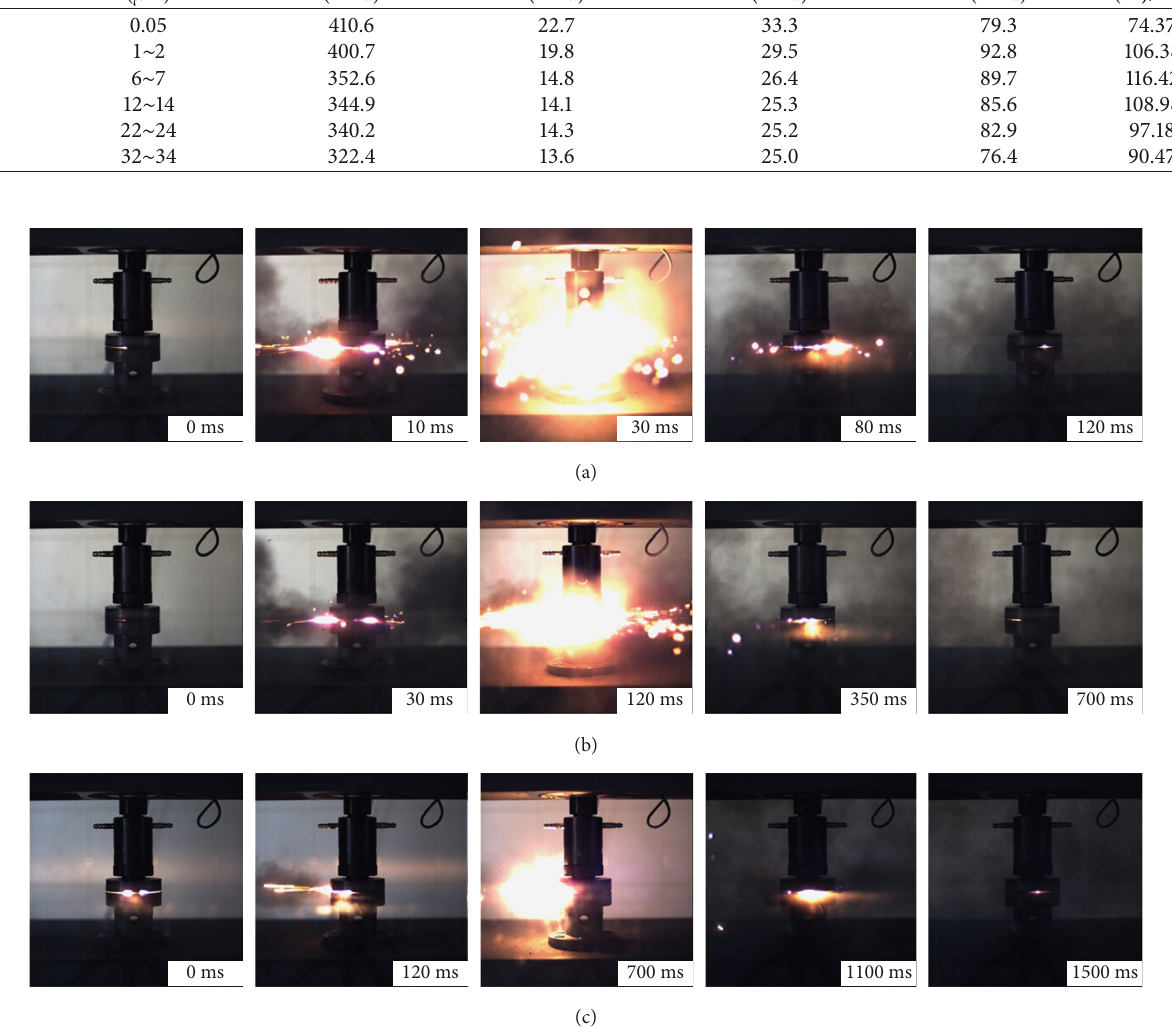
Figure 5: Reaction phase of specimens #1, #2, and #3 under quasistatic compression. (a) Specimen #1. (b) Specimen #2. (c) Specimen #3.